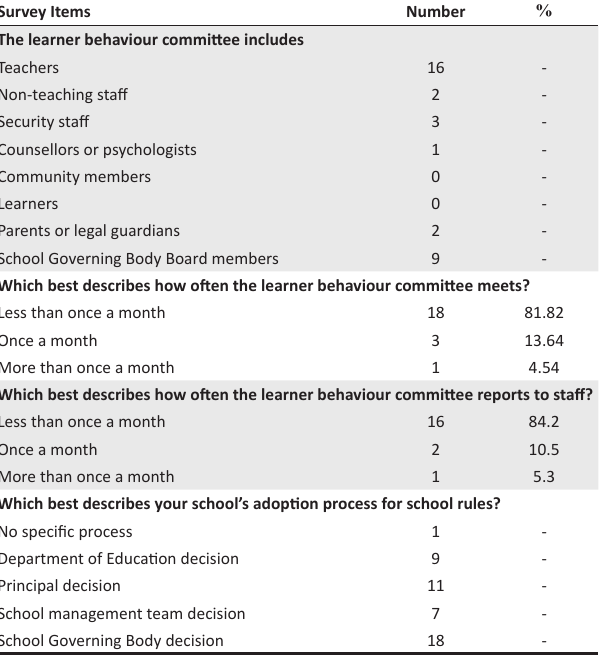
TABLE 2: Leadership team implementation and coordination. Survey Items Number